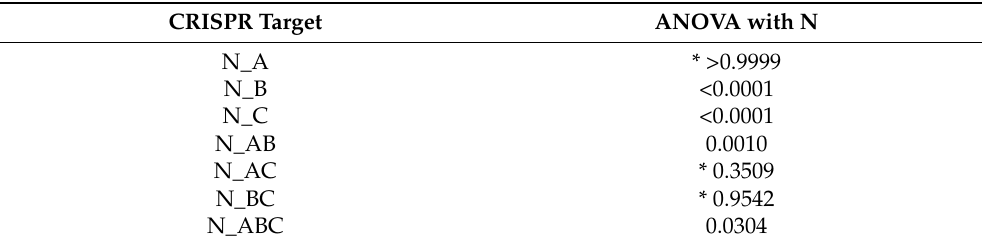
Figure 7. N gRNA mismatch comparison. Data presented as the mean of triplicate replicates with error bars representing the standard error. Graphs in the top row compare number of SNPs while graphs on the bottom compare the SNP location at Day 2 post-infection. Table 8. One-way ANOVA comparison of N gRNA mismatches. p values with an asterisk indicate the percent reduction is not significantly different from that of the N control